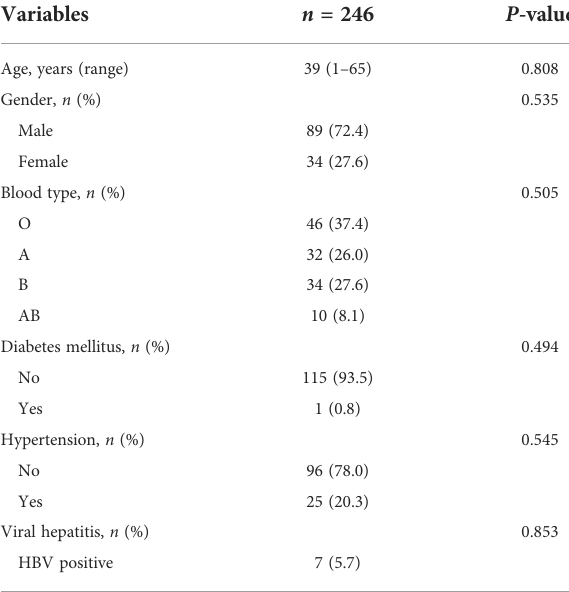
TABLE 3 Baseline characteristics of donors and their association with treated